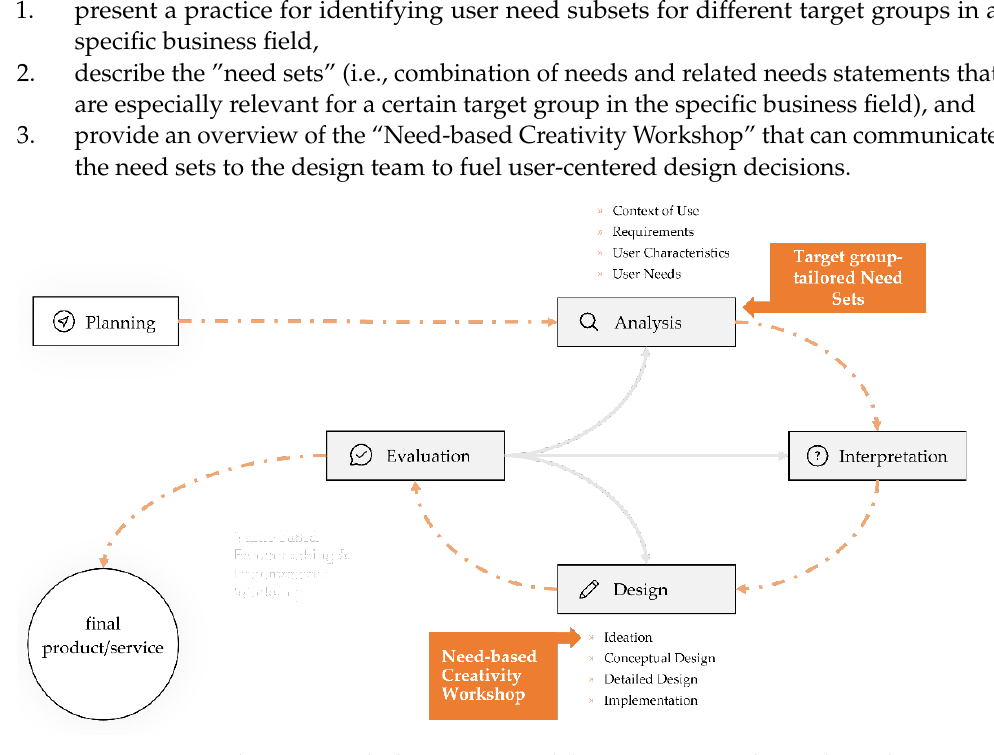
Figure 1. Our approach augments the human-centered design process: in the Analysis phase, target group-tailored need sets are derived. In the Design phase, the Need-based Creativity Workshop can be conducted to communicate the needs to the design team and use them as a basis for product and service innovation.